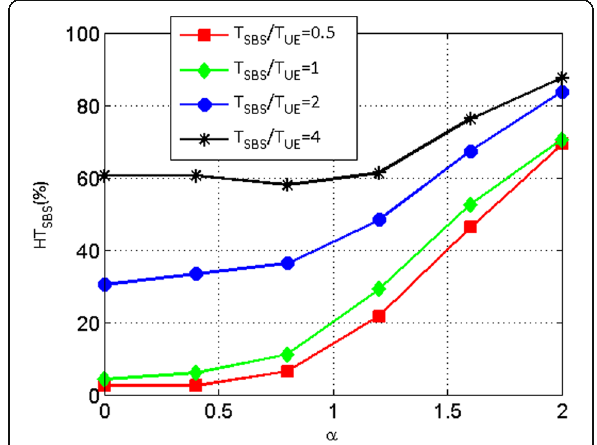
Fig. 18 Impact of network feature to the hit rate in the UE level ( α ¼ 1 ; d UE ¼ 4 ; N UE ¼ 60 ; T SBS